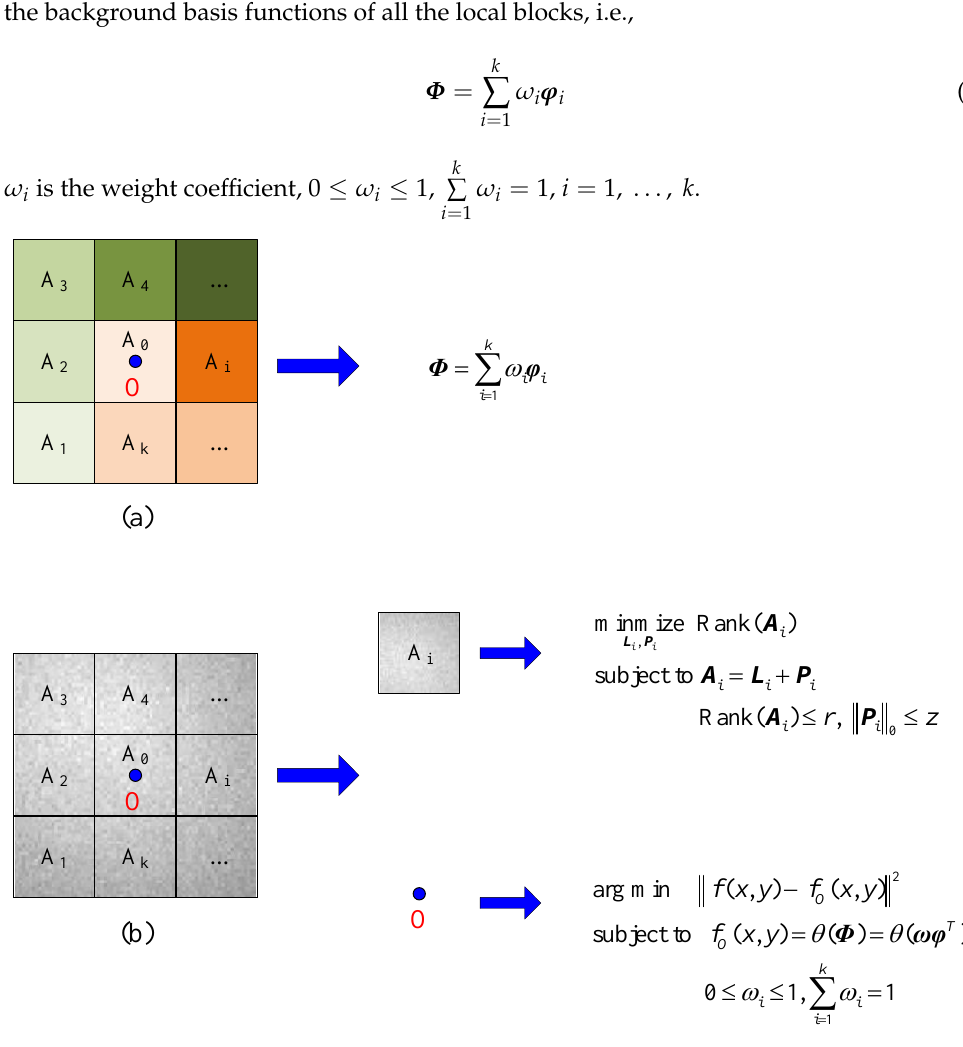
Figure 5. The schematic diagram of SPB algorithm. ( a ) The background model of region B in the presence of interference. ( b ) The schematic diagram of strong vignetting background modeling.